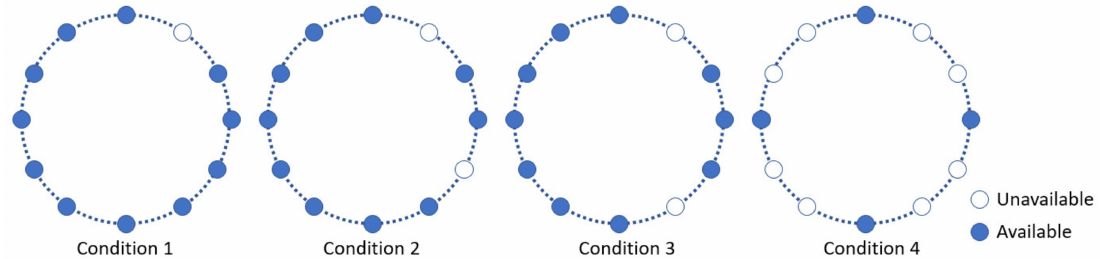
Figure 4. Illustration of unavailable records